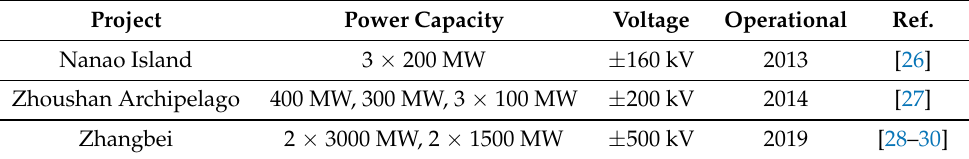
Table 1. Operational MT-HVDC networks in China with VSC technology